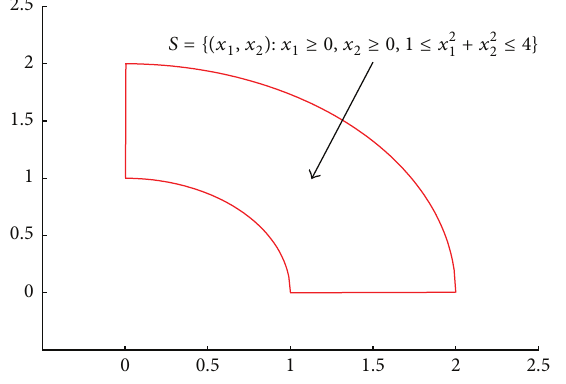
Figure 3: The nonconvex set 𝑆 in Example